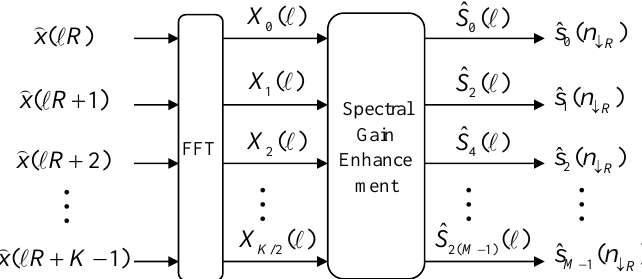
Figure 1. The block diagram of the analysis stage of a hearing device filter bank with a spectral enhancement algorithm.